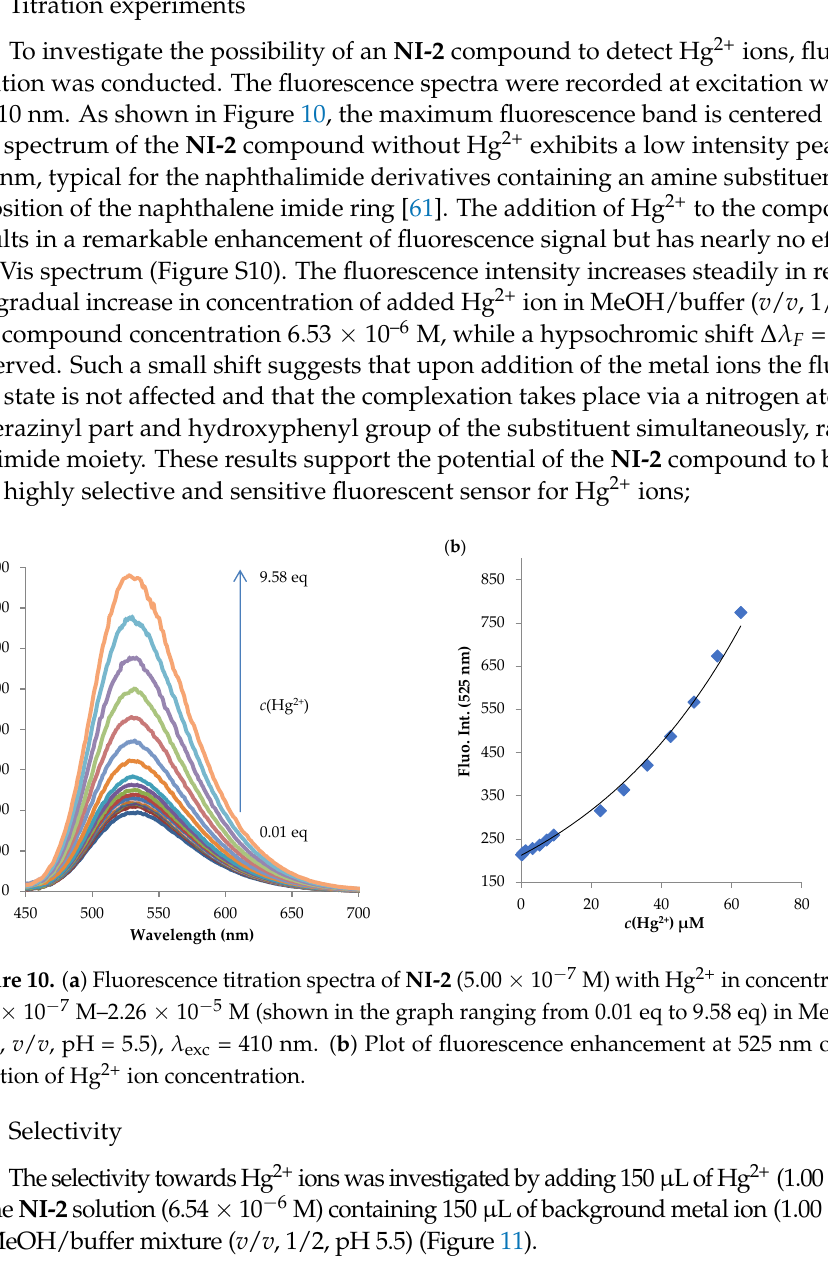
tion of Hg 2+ ion concentration.